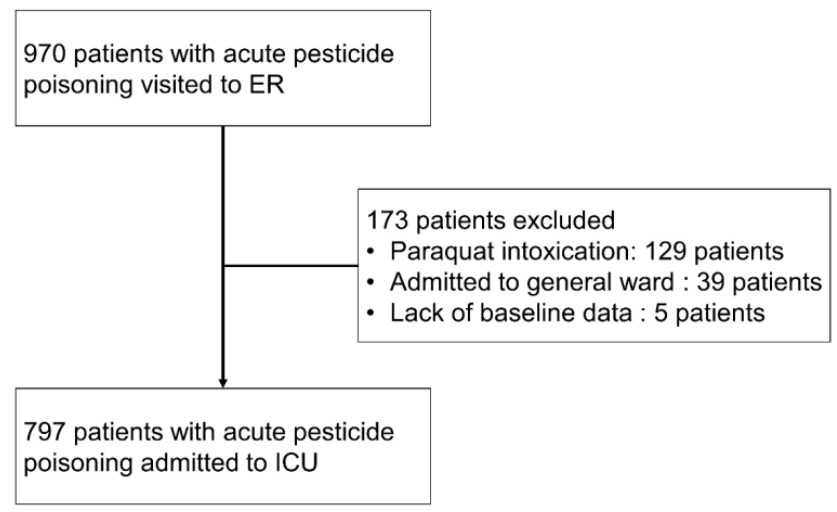
Figure 1. Flow chart showing the inclusion and exclusion of patients in the study. Table 1. Baseline characteristics of enrolled patients ( n = 797).